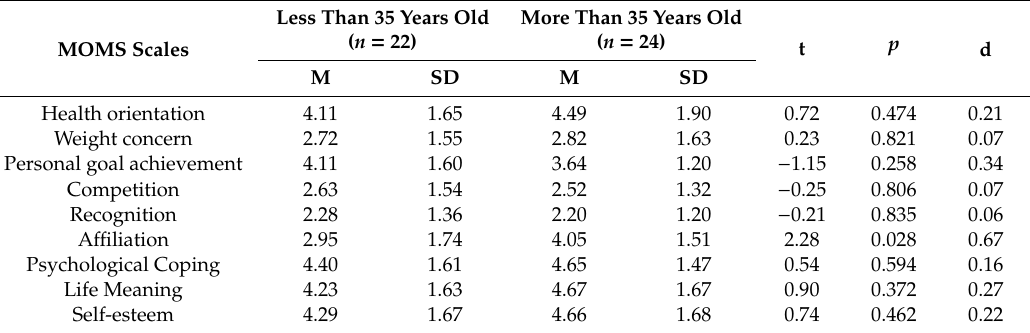
Table 3. Motivations of singles aged under 35 and over 35.